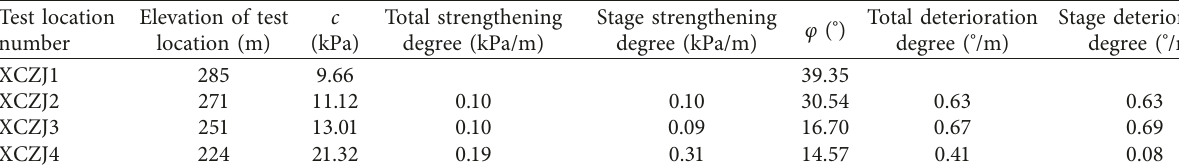
Figure 7: Variation of in situ test peak strength with different test locations. Table 1: Cohesion and friction angle of the in situ test.